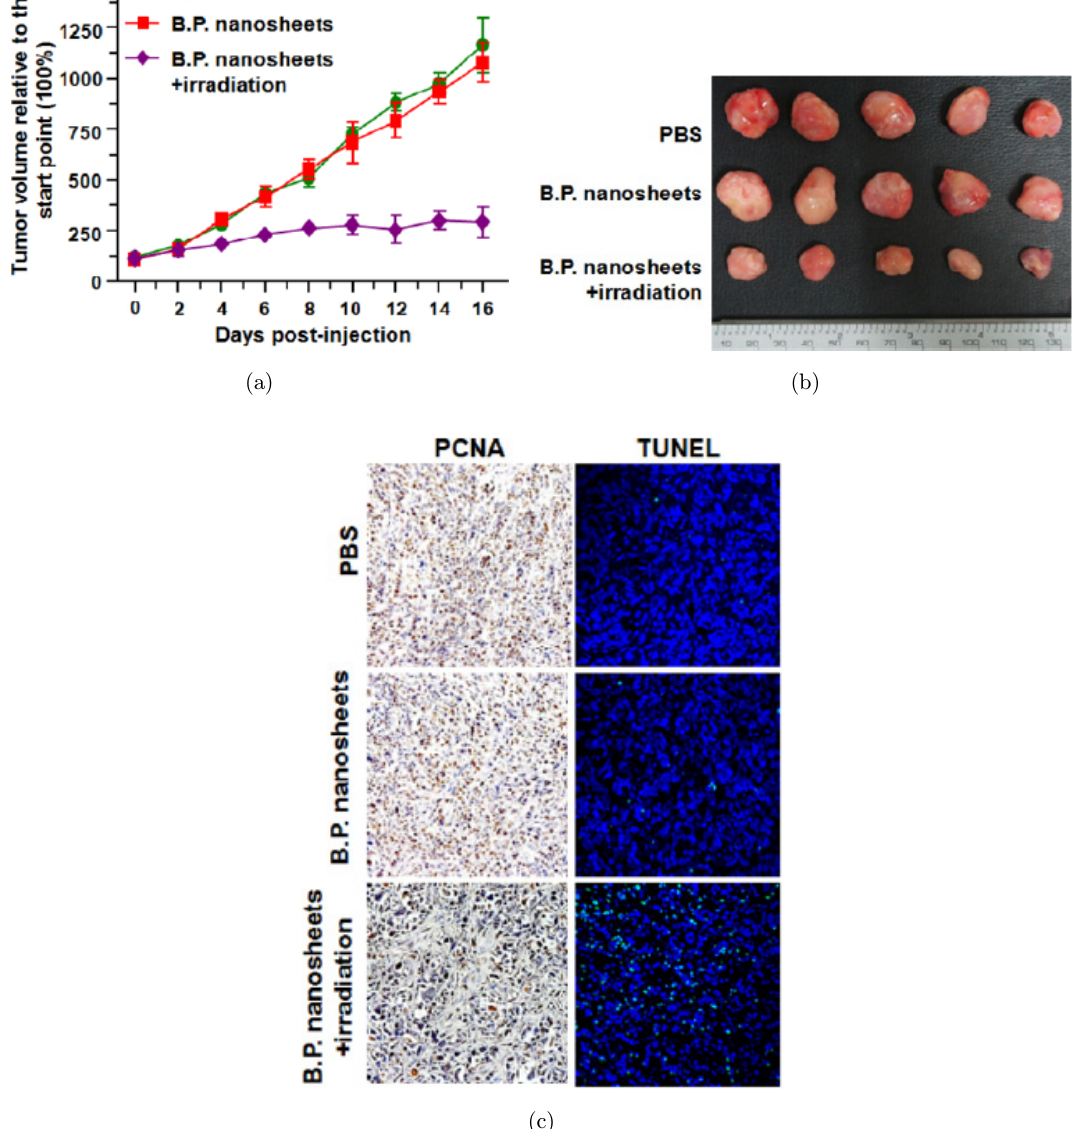
Fig. 4. In vivo PDT. (a) Tumor volume of di®erent time post-injections. (b) Tumor pictures of experimental group and control group after treatments. (c) PCNA and TUNEL analysis of tumor